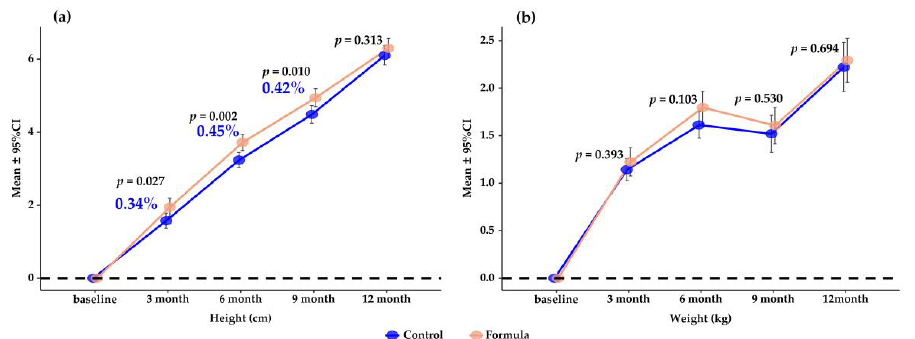
Figure 3. Mean (95%CI) change in height ( a ) and weight ( b ) over 6 and 12 months compared to baseline. p values are for the differences between groups by Student’s t -test. Percentages are incremental gains in height and weight.